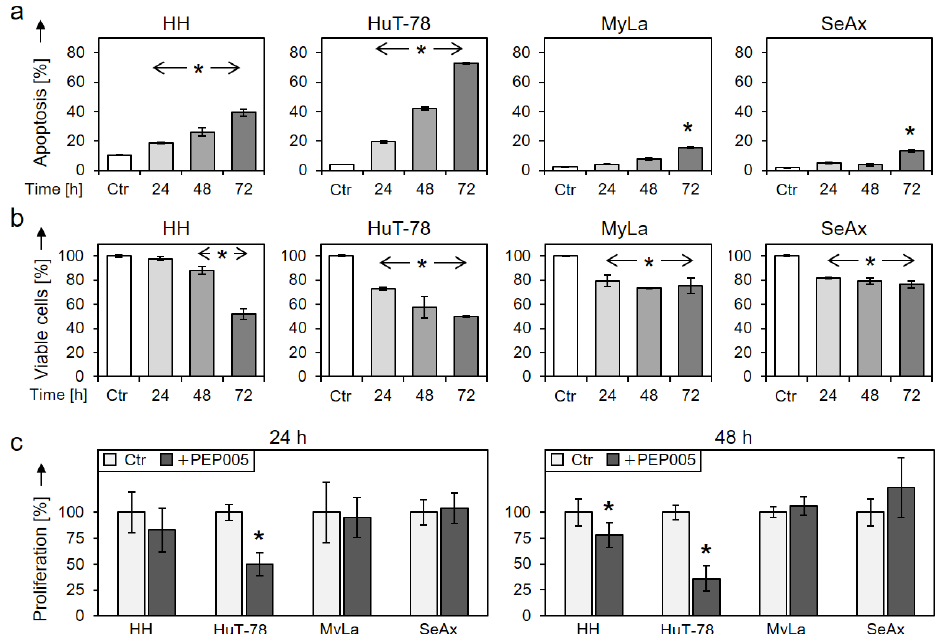
Figure 2. Time dependency and cell proliferation. Time dependency of ( a ) induced apoptosis and of ( b ) reduced cell viability were determined in four cell lines at 24, 48 and 72 h of treatment with 50 nM PEP005. For cell viability, non-treated controls were set to 100% (Ctr). ( c ) Cell proliferation rates of CTCL cell lines at 24 and 48 h in response to 50 nM PEP005 were determined by WST-1 assay. Values are given in relation to non-treated controls (Ctr), set to 100%. At least two independent experiments were performed, each one with triplicate values; statistical significance was calculated from all values (* p < 0.05).